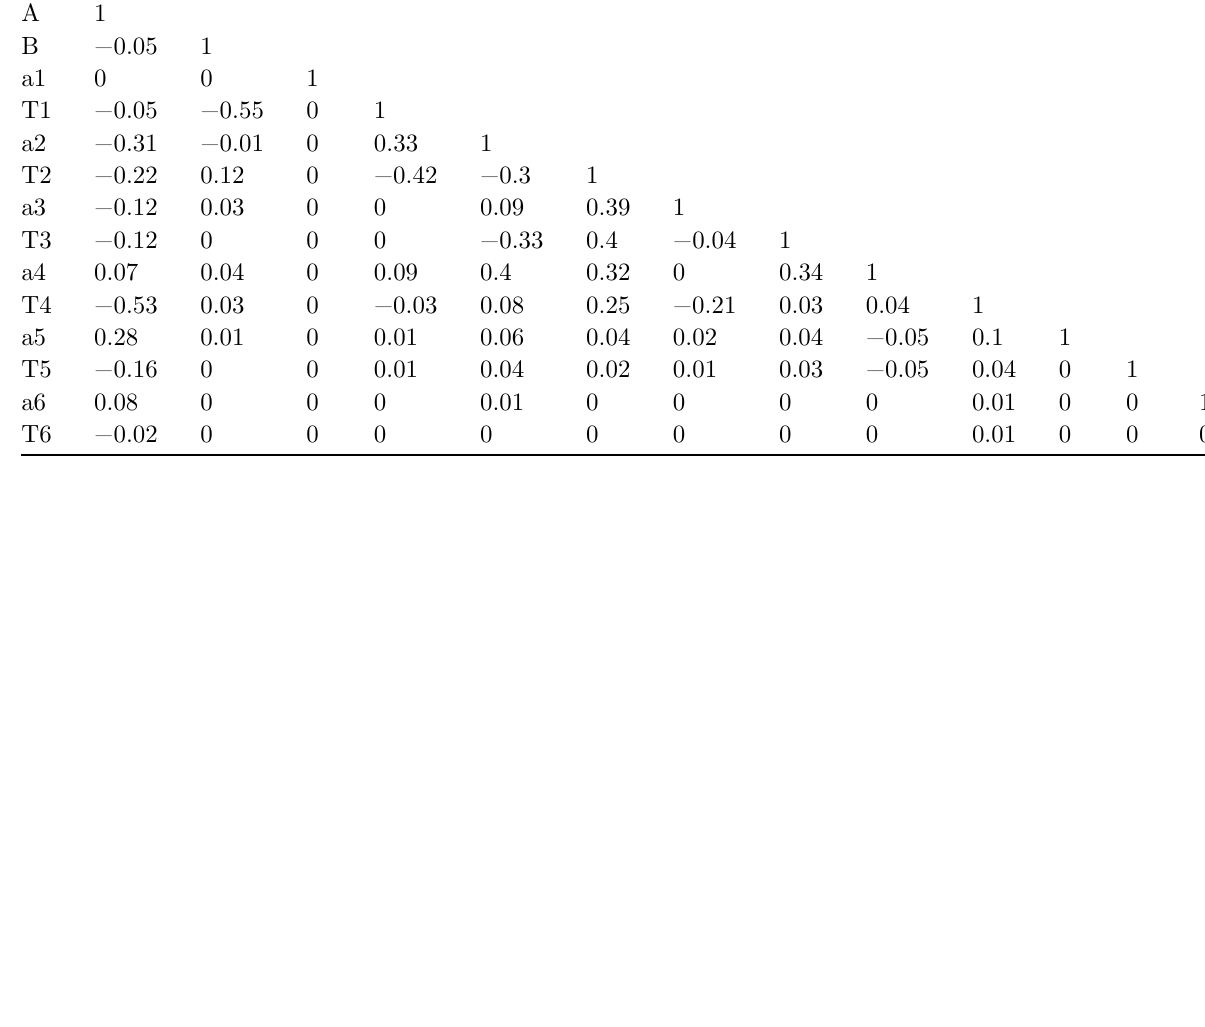
, T ) obtained in the LSF processing of the model decay curve calculated with i i